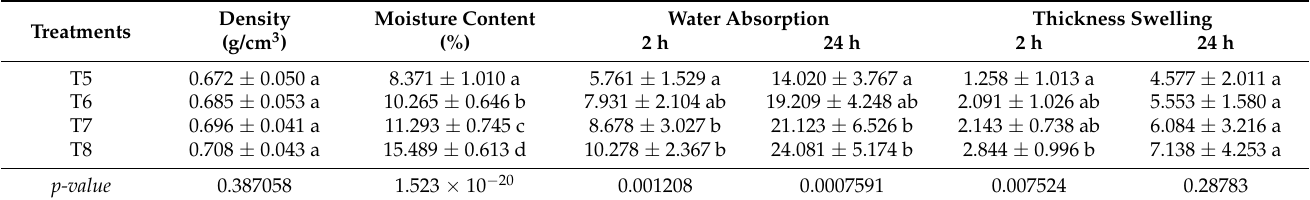
Table 4. Results of physical properties analyzed for panels with 15 vol.% of